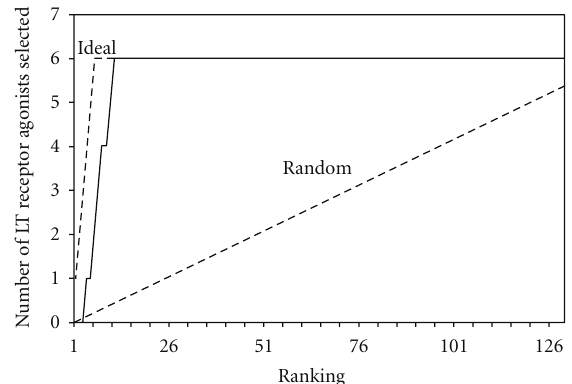
Figure 6: Enrichment curve for various GPCR ligands docked into the predicted active-state BLT1